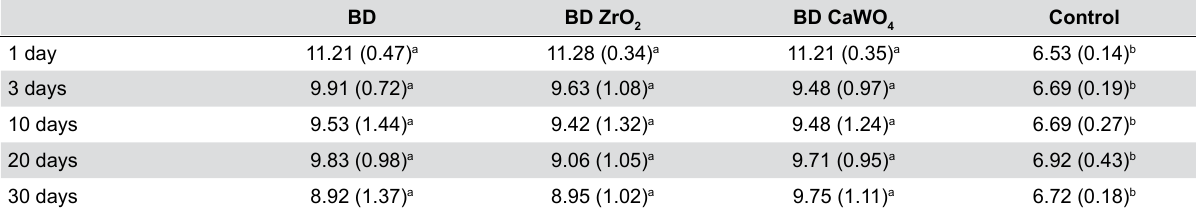
Different letters in the lines indicate statistically significant differences between materials (P<0.05)